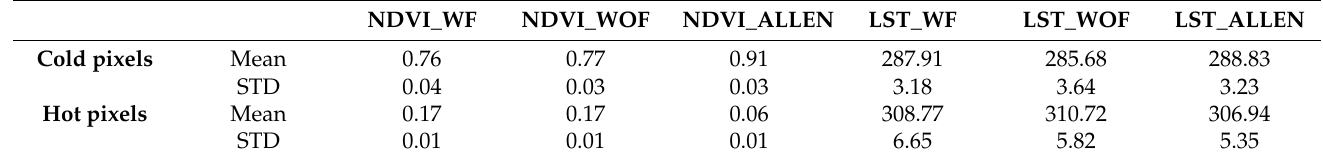
Table 2. Overall mean and standard deviation (STD) of NDVI (dimensionless) and LST (K) with the different endmember selection methods for all flux tower sites (2270 images).